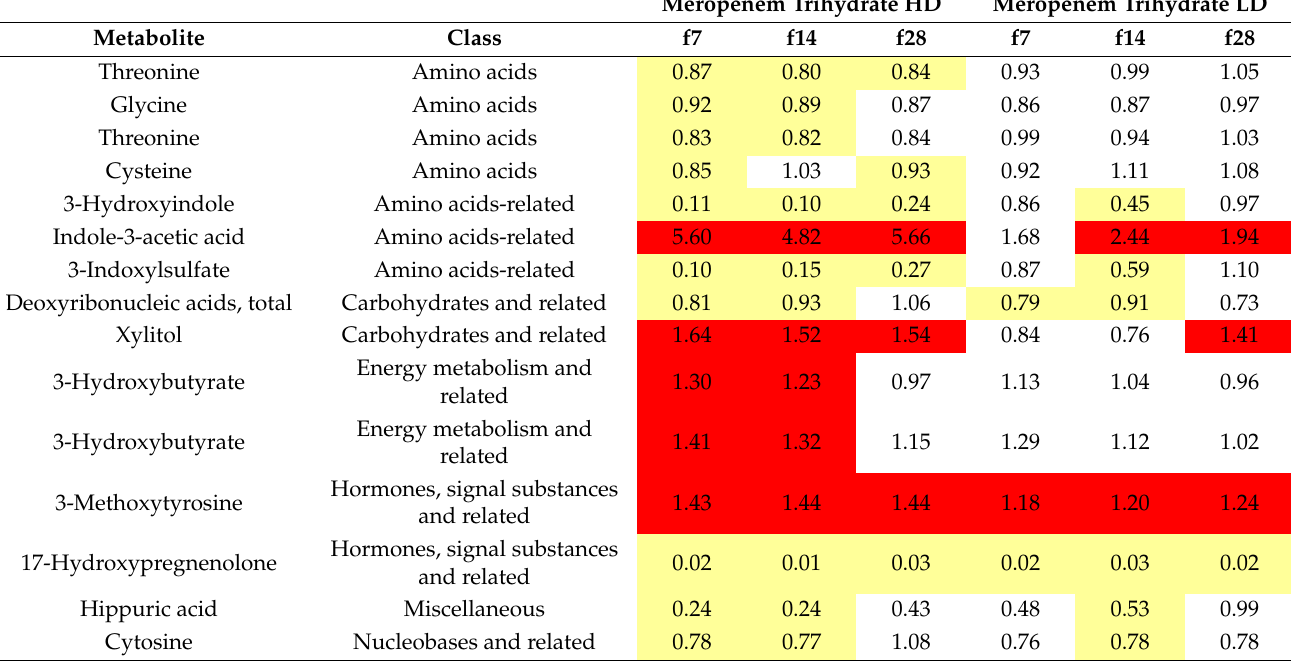
Table 6. Meropenem-induced plasma metabolite fold changes in female (f) Wistar rats (N = 5 per group) dosed with 100 (LD) and 300 (HD) mg/kg bw/day observed on 7, 14, and 28 days (f7, f14, and f28). Statistically significant changes (Welch t -test; p -value < 0.05) are shown where red boxes mean a significant increase in the respective plasma metabolites and yellow boxes mean a significant reduction compared to control levels.